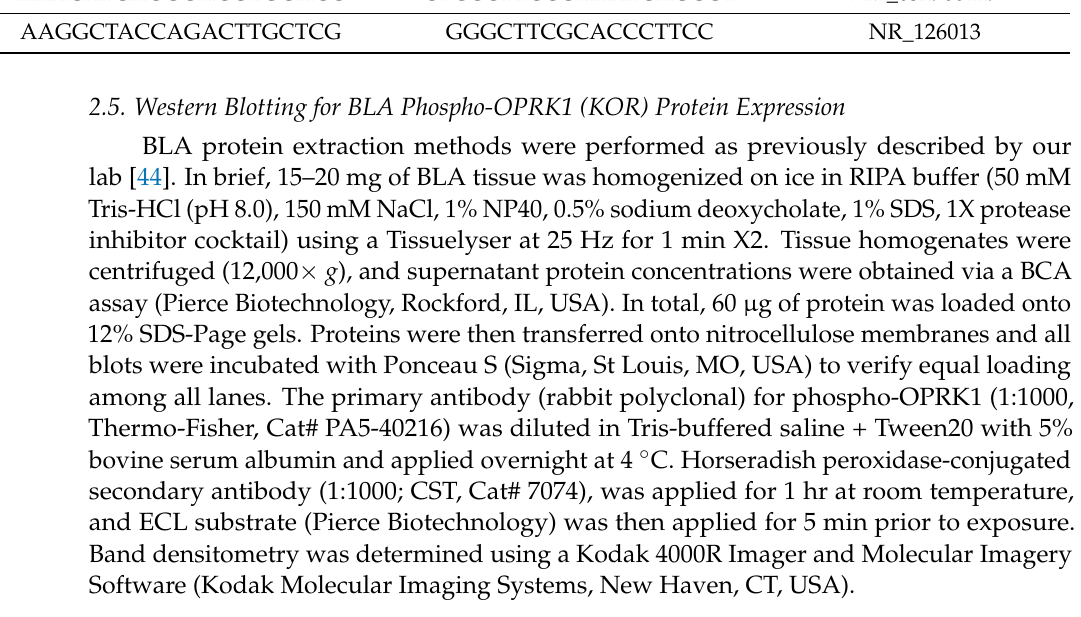
Table 1. Primer sequence for basolateral amygdala gene expression analyzed by qPCR. Gene Forward (5 (cid:48) –3 (cid:48) ) Reverse (3 (cid:48) –5 (cid:48) ) Accession Number